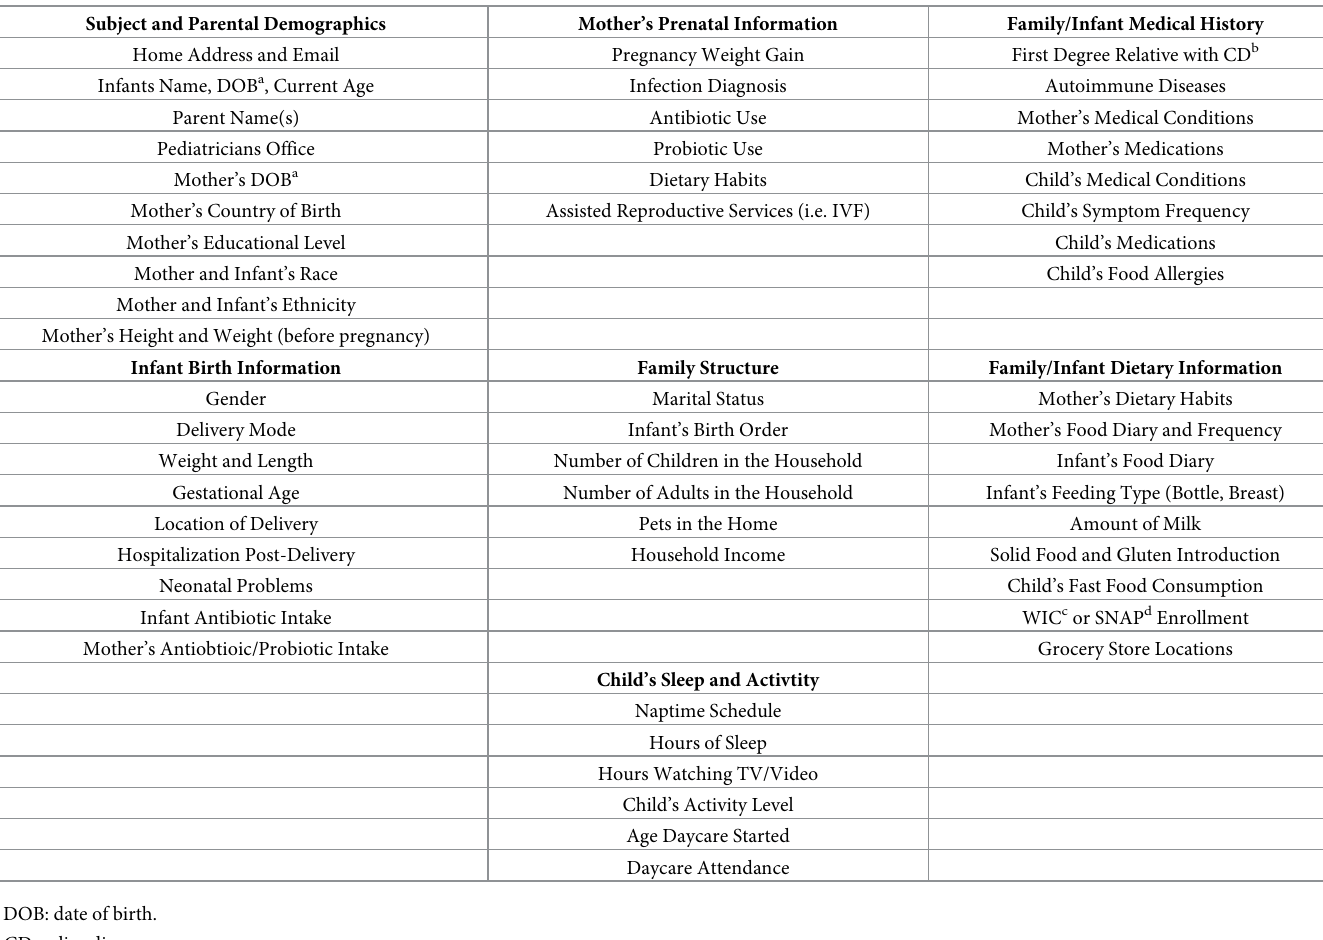
Table 1. Data collection from surveys administered to the parents of children in